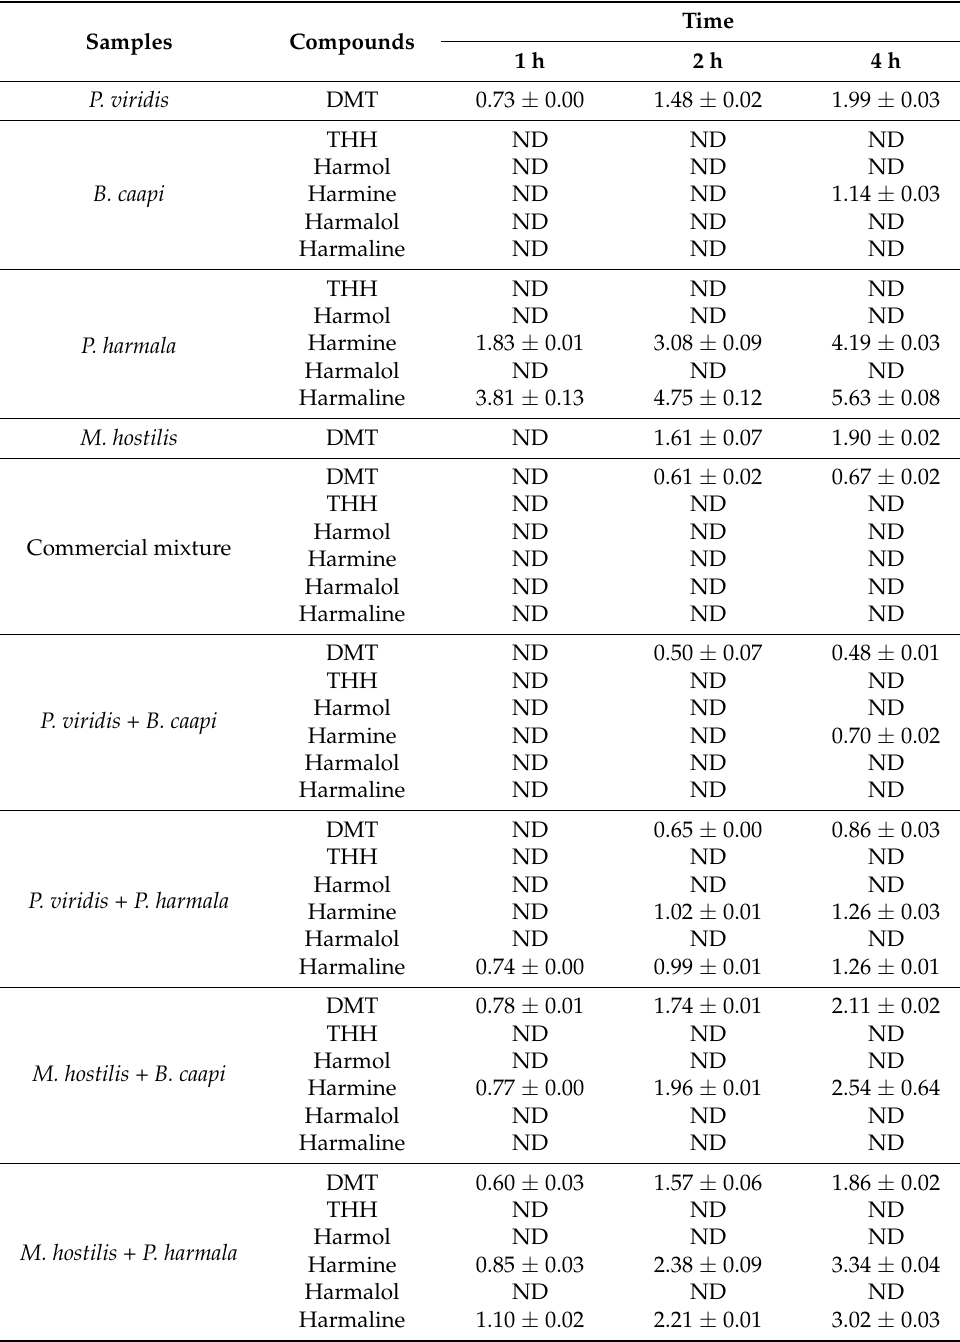
Table 7. Concentration of the main compounds of Ayahuasca in the aliquots collected after the different incubation times with the digested extract (Mean µ g/mL) ±